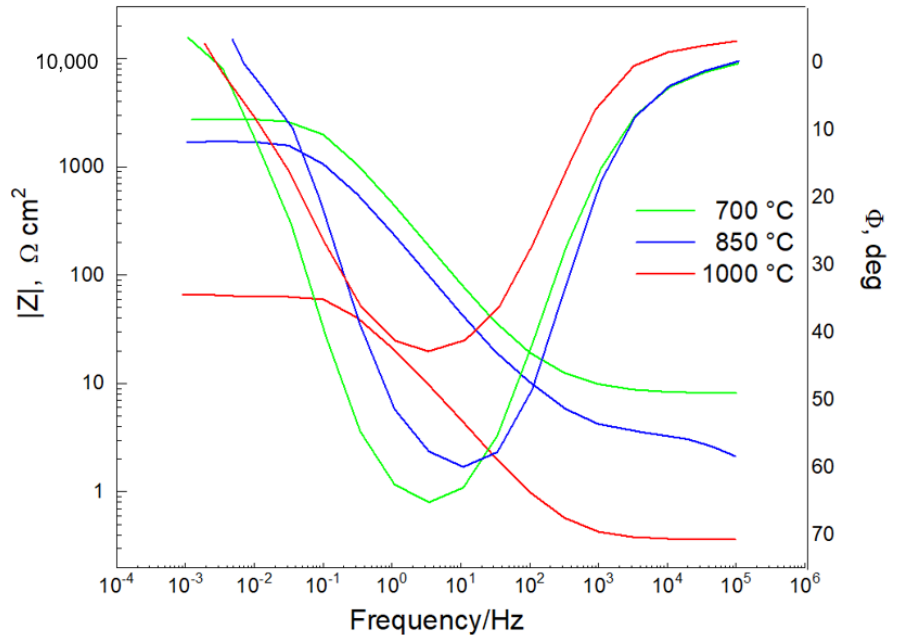
Figure 6. Bode diagram for the Bi 3 La 1 Ti 3 O 12 composite.